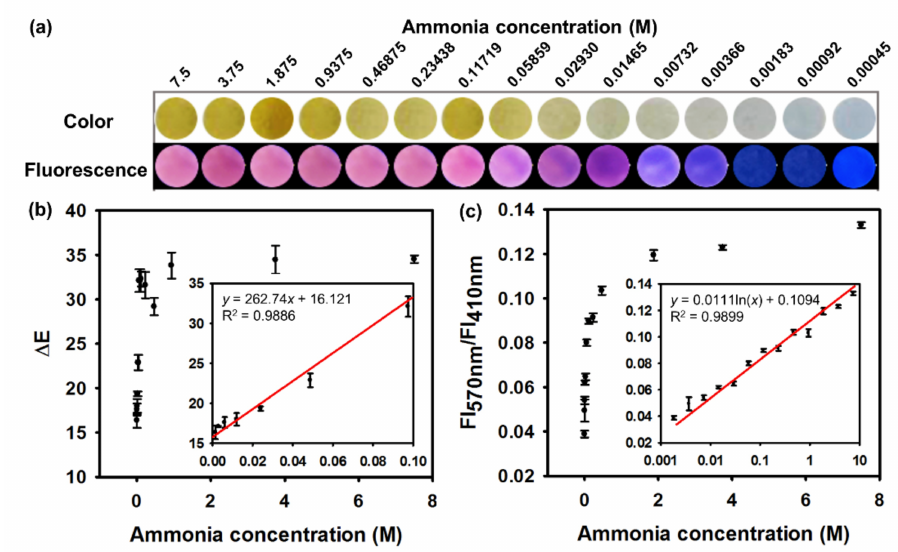
Figure 2. The color and fluorescence changes of the H + MQ-loaded paper chip in response to varied concentrations of ammonia. ( a ) Photographs, ( b ) ∆ E, and ( c ) FI 570nm /FI 410nm of the reacted paper chips under different ammonia